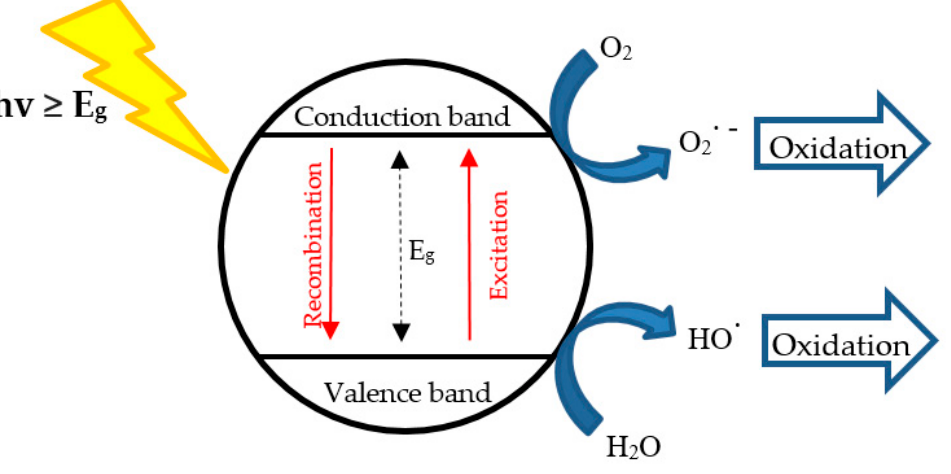
Figure 1. Principle mechanism of photocatalysis.